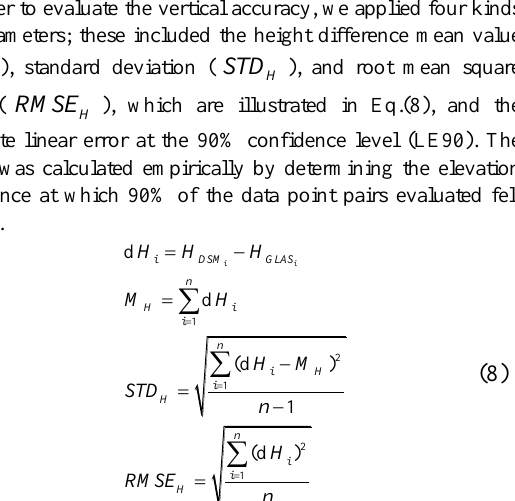
better than 1.0 m theoretically in the vertical direction.